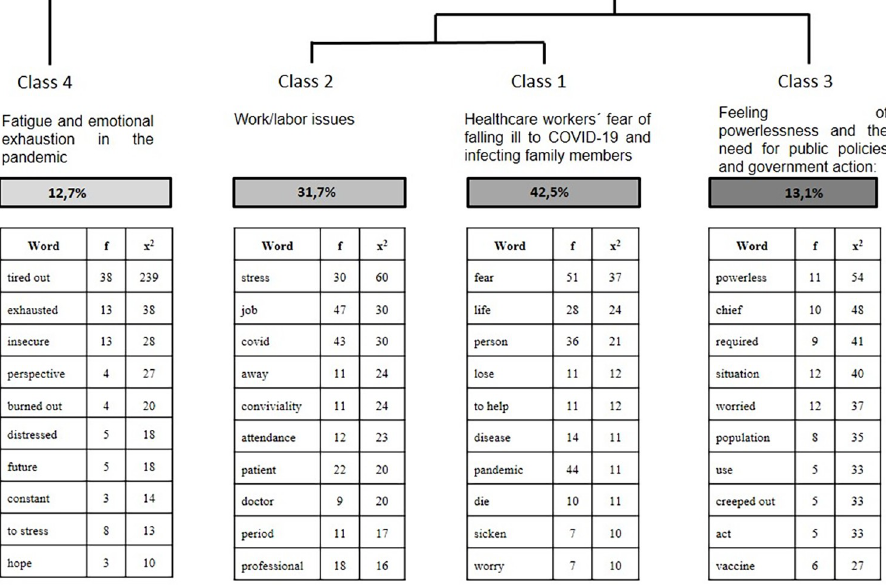
Fig 2. Dendrogram of downward hierarchical classification of classes. Source: COVIDPRO Project (2020). Rio de Janeiro–Brazil, 2020. (N = 554).